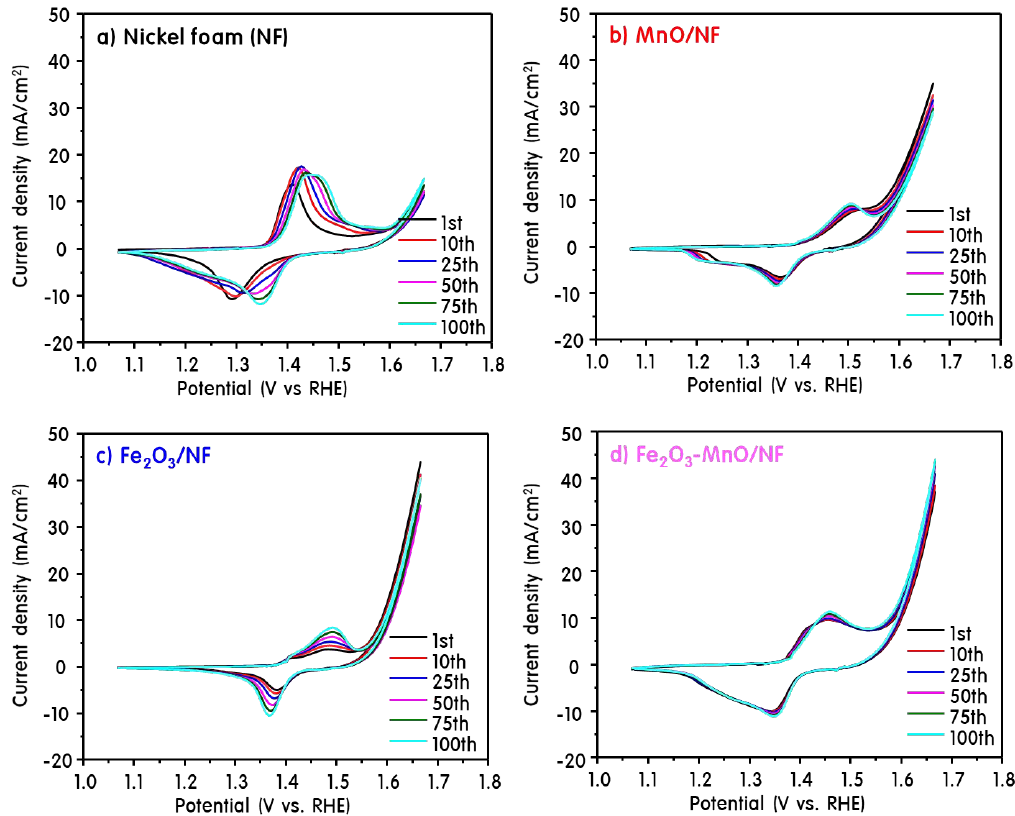
Figure 3. Cyclic voltammetry (CV) curves obtained when NF ( a ), MnO / NF ( b ), Fe 2 O 3 / NF ( c ), and Fe 2 O 3 -MnO / NF ( d ) samples were used as the working electrode.